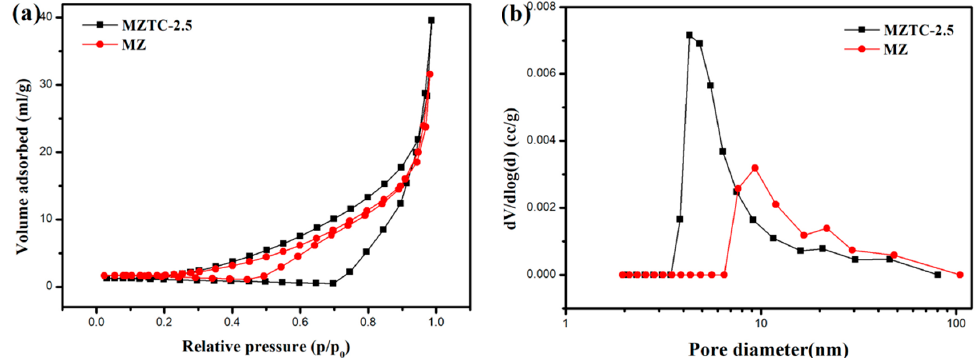
Figure 3. ( a ) N 2 adsorption–desorption isotherms of MZ and MZTC-2.5; ( b ) pore size distribution curves of MZ and MZTC-2.5.